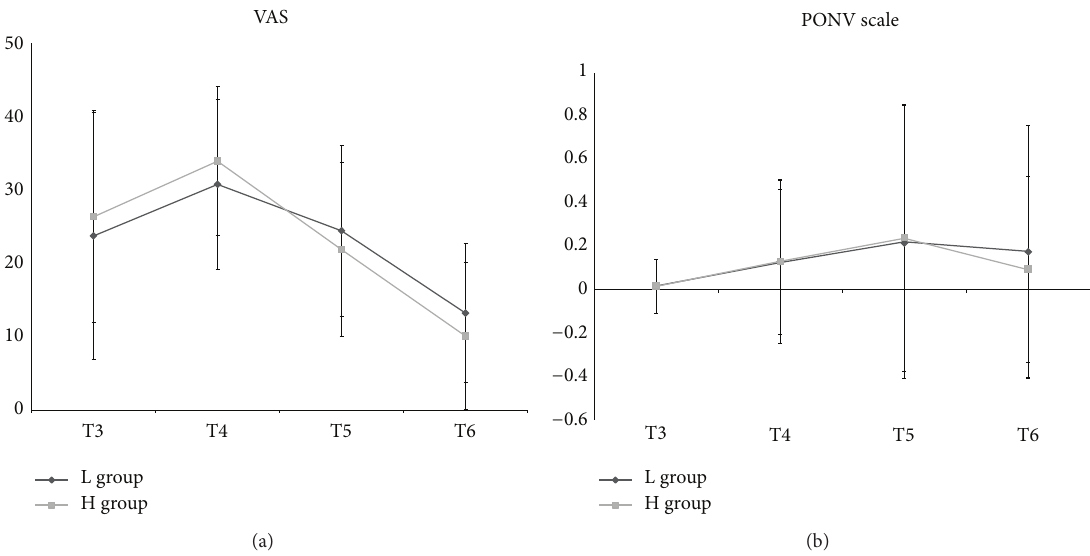
Figure 3: Postoperative pain and postoperative nausea and vomiting (PONV). (a) VAS: visual analogue scale. (b) PONV scale. L group: propofol-low dose remifentanil group; H group: propofol-high dose remifentanil group; T3: on arrival at postanesthetic care unit (PACU); T4: 30 min after arrival at PACU; T5: at 6h after discharge from PACU; T6: at 24 h after discharge from PACU (T6).